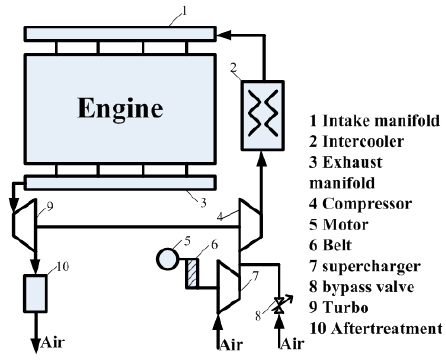
Figure 1. System schematic of SAC system. Table 1. Parameters of the SC driven system.